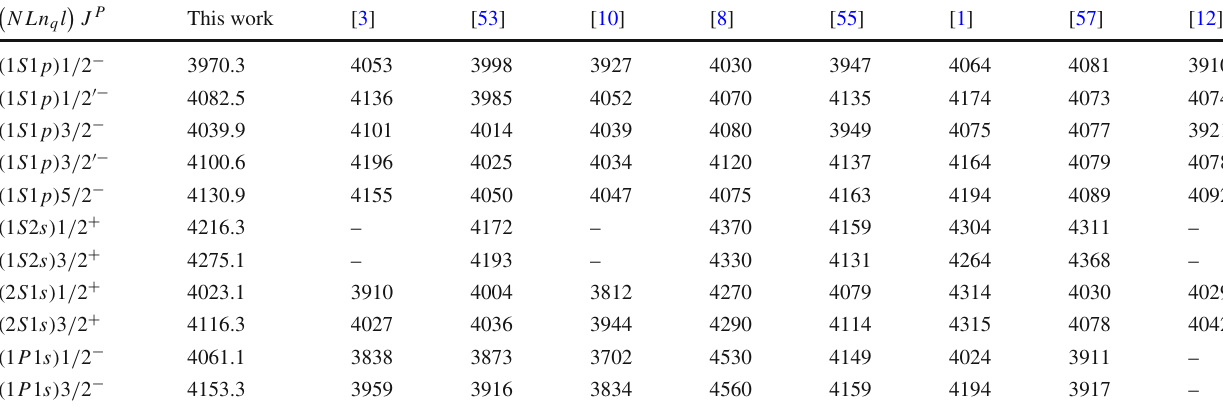
Table 10 Mass spectra of the baryon (cid:2) cc (in MeV). Our results are obtained by the respective sum of the mean mass of the (cid:2) cc in Table 3, the binding energy shift(vanishes in 1S1s wave) in Table 9 and its splittings in Sect. 3 with the couplings given in Sect. 4